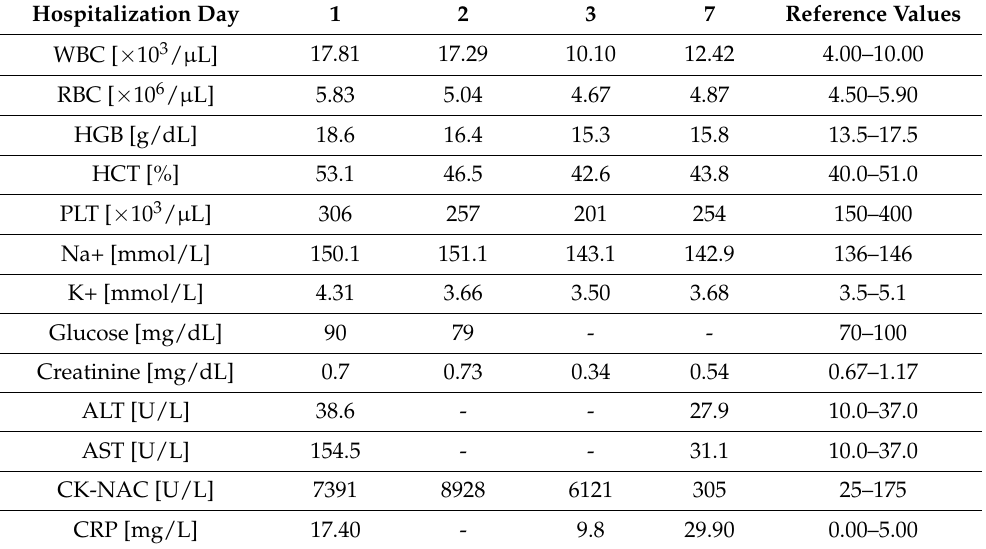
Table 1. Laboratory tests performed on the